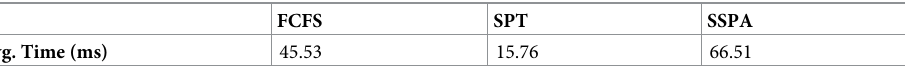
Table 7. Elapsed times for FCFS, SPT, and SSPA in JSSP with